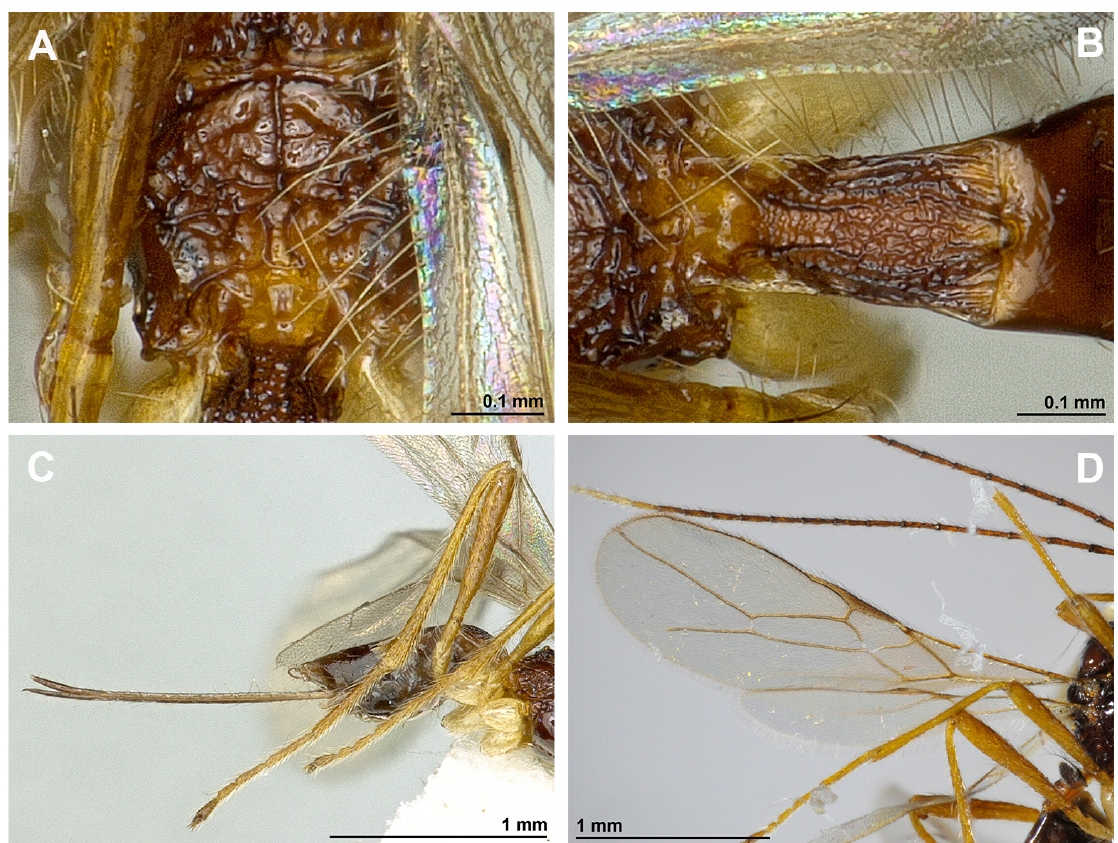
Fig. 30. Asobara kenyaensis Peris-Felipo, 2014, ♀, holotype (BMNH). A . Propodeum. B . First metasomal tergite, dorsal view. C . Hind leg, metasoma and ovipositor, lateral view. D . Fore and hind